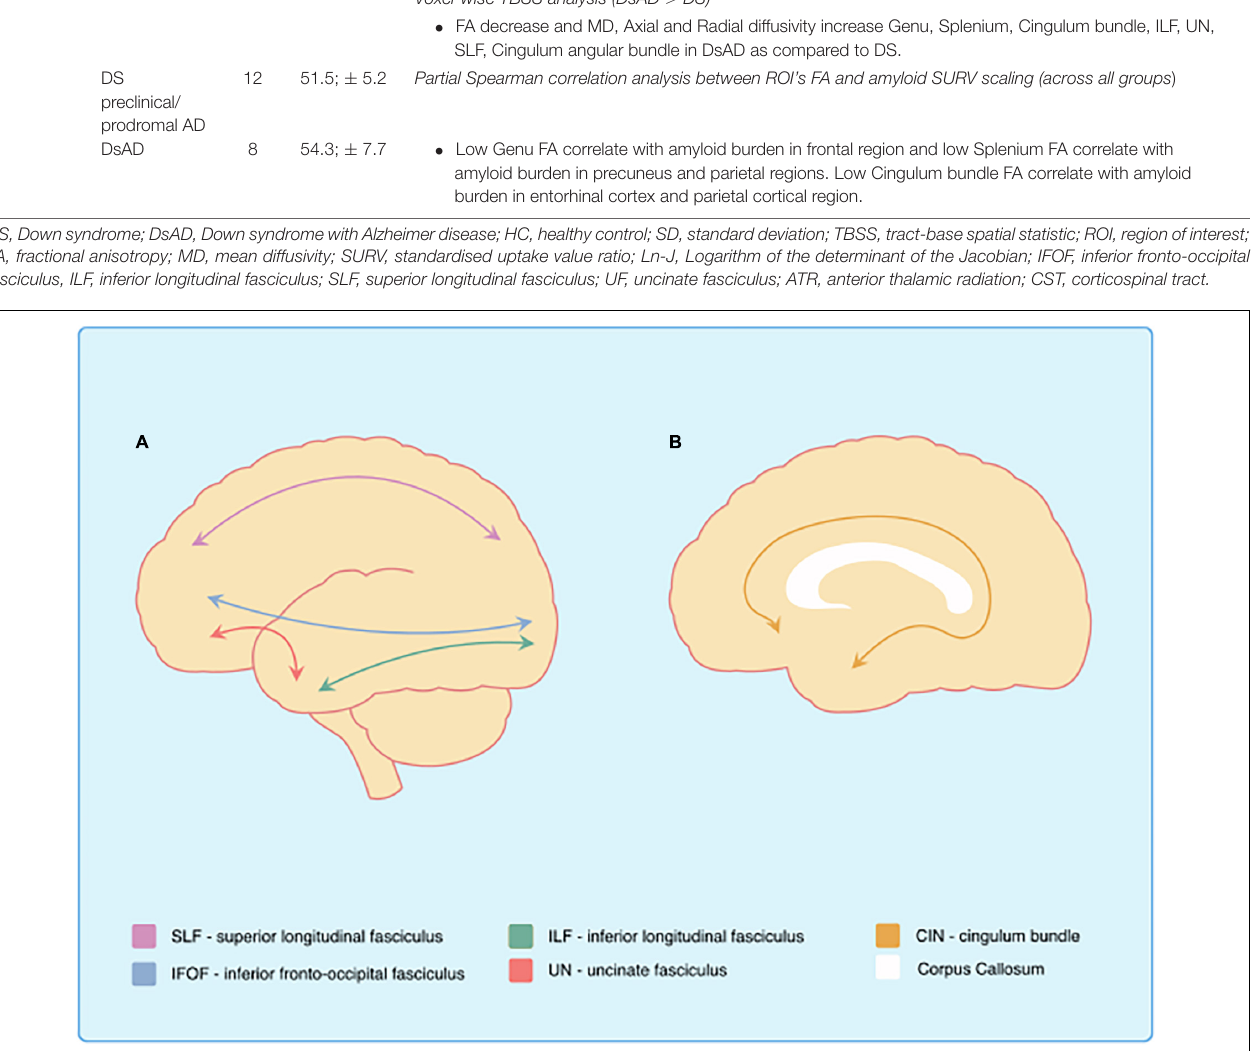
Despite the different functional interpretations that might